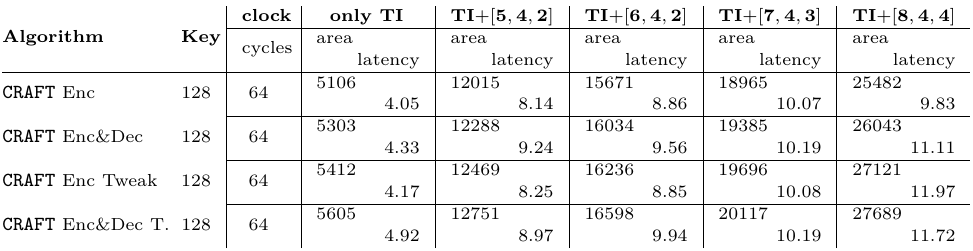
Table 9: Area (GE) and Latency (ns) of round-based Threshold Implementations of CRAFT with 3 shares considering an M ∗ -bounded multivariate adversary with an t = d − 1 [ n, k, d ] code, using IBM 130 nm ASIC